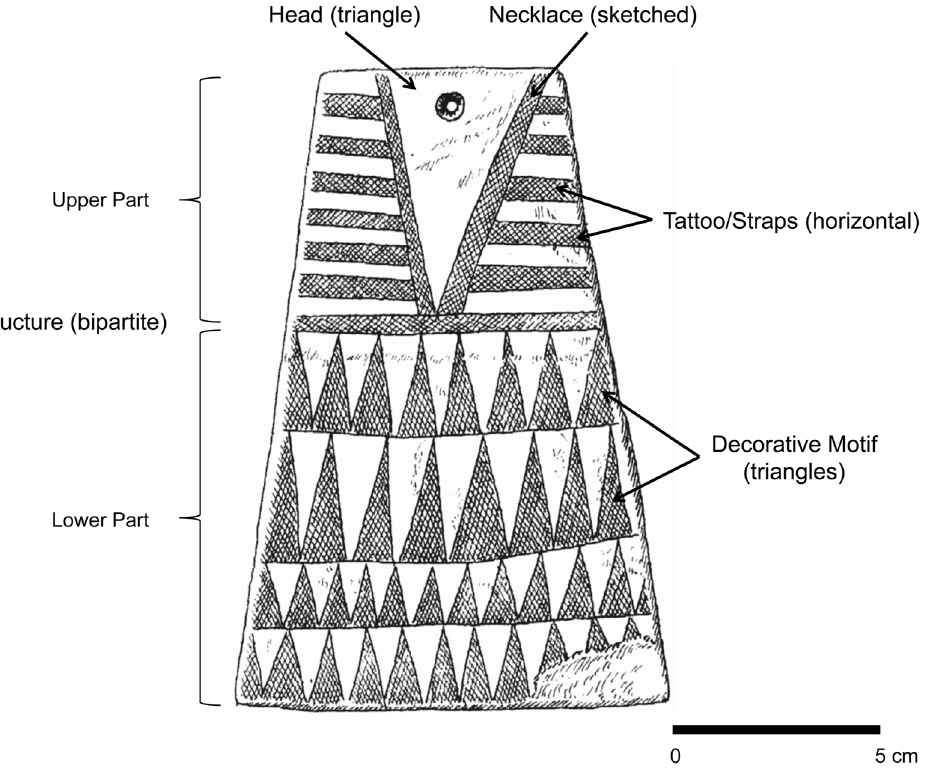
Figure 2. Characters used in the analysis and abbreviations: Decorative Motif (DM), Structure (ST), Traps/Tattoo (TT), Necklace (NK), and Head (H). Terms in parentheses are particular character states for this example (see Fig. 3). After [31].